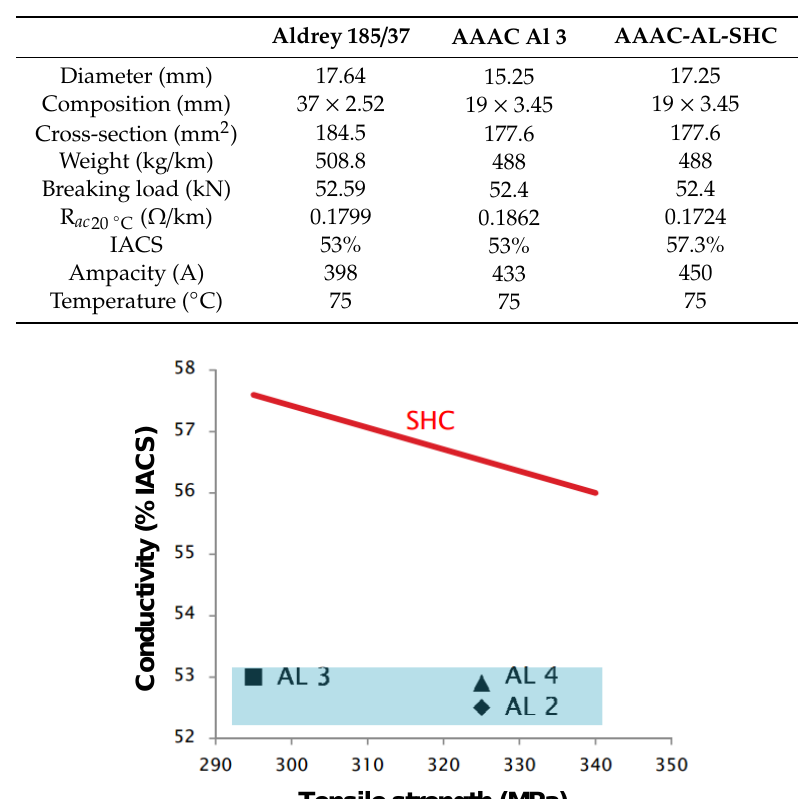
Table 9. Main properties of the innovative conductor for distribution OHLs compared with two reference traditional conductors.